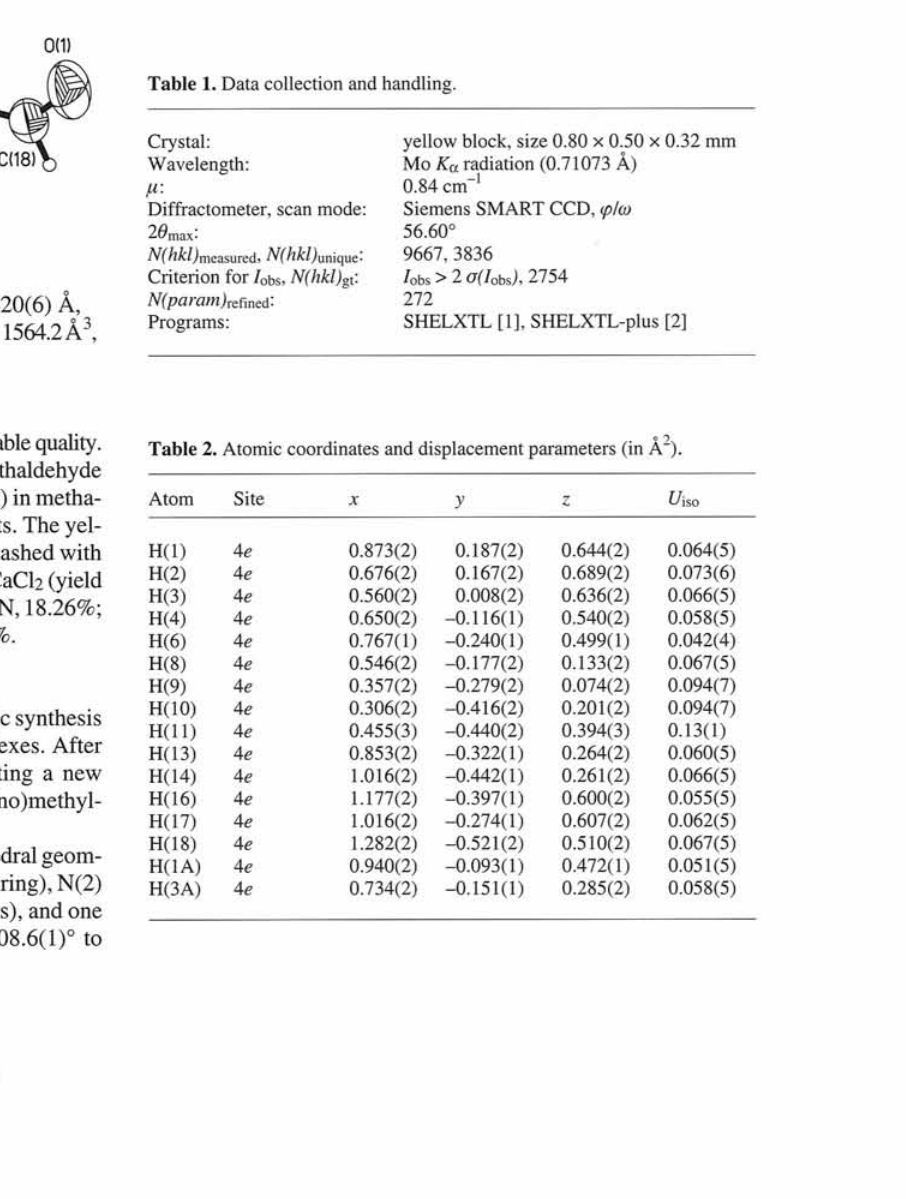
Table 1. Data collection and handling.